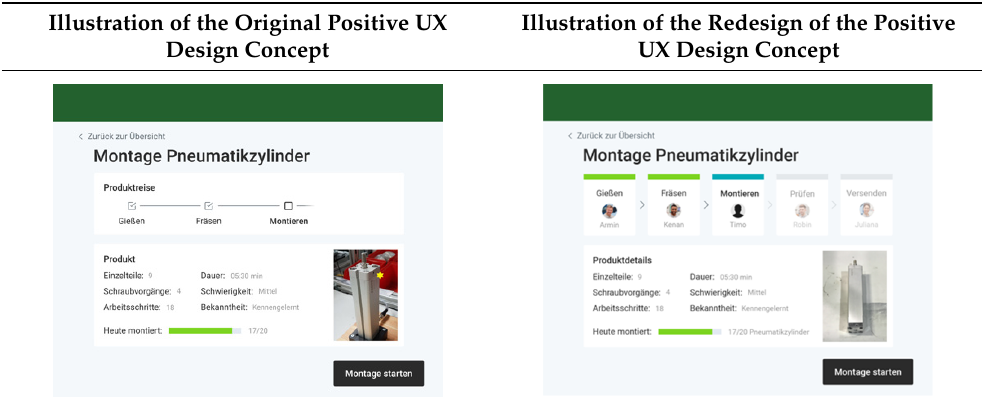
Table 6. Original positive UX design concept and respective redesign of “Product overview”.